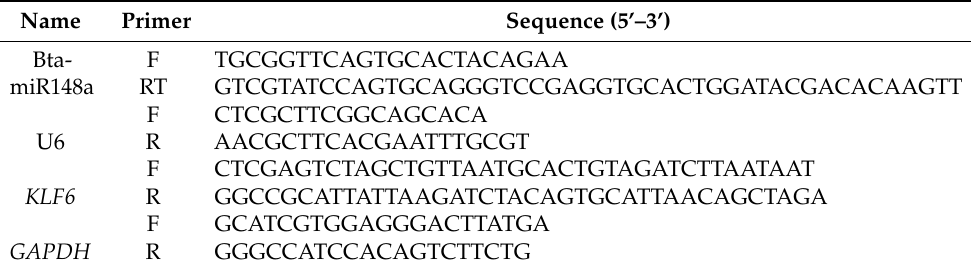
Table 1. Real-time PCR primer sequences.